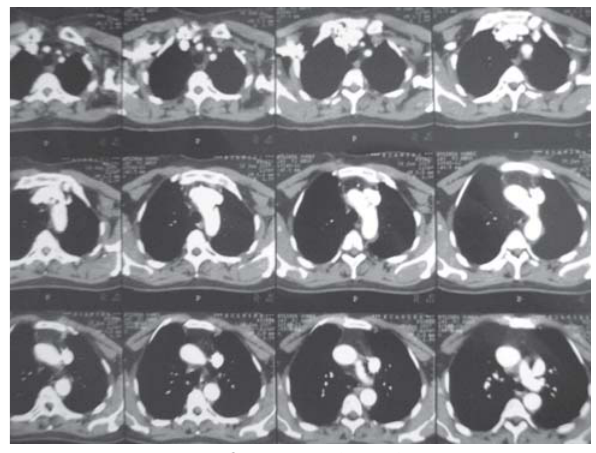
Fig.1 - A angiotomografia computadorizada mostrou a presença de veia cava superior patente à direita, presença de tronco venoso braquiocefálico esquerdo drenando para veia cava superior esquerda persistente, a qual desce ântero-lateralmente ao arco aórtico e drena para o seio coronariano, posteriormente ao átrio esquerdo. Veia cava inferior presente. Arco aórtico e vasos supra- aórticos com calibre e contrastação preservados